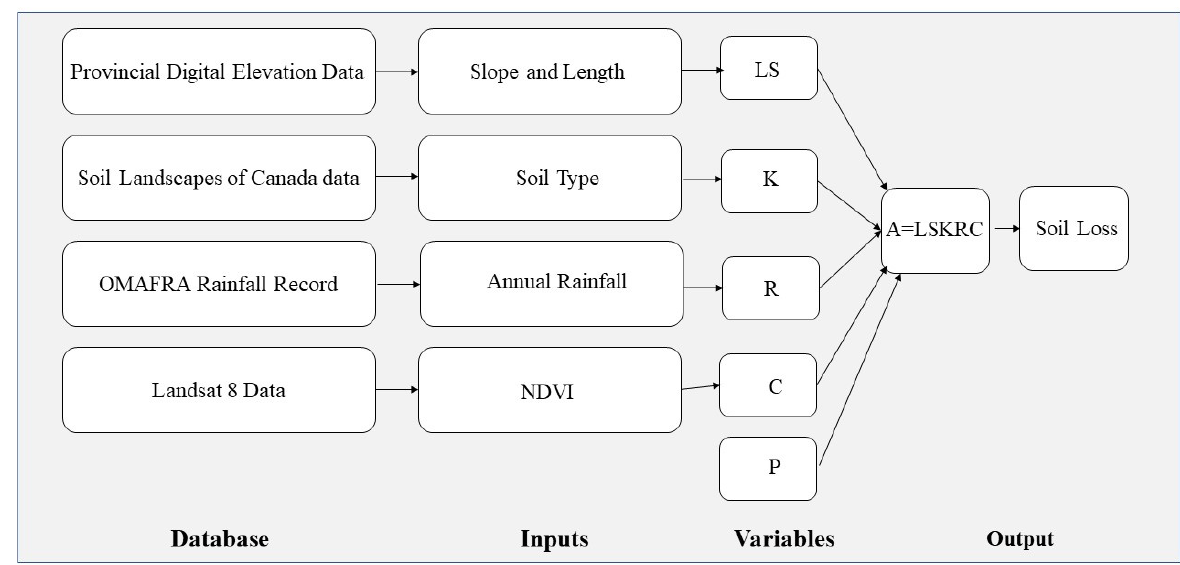
Figure 4. Flow chart of Universal Soil Loss Equation (USLE) model using ArcMap.